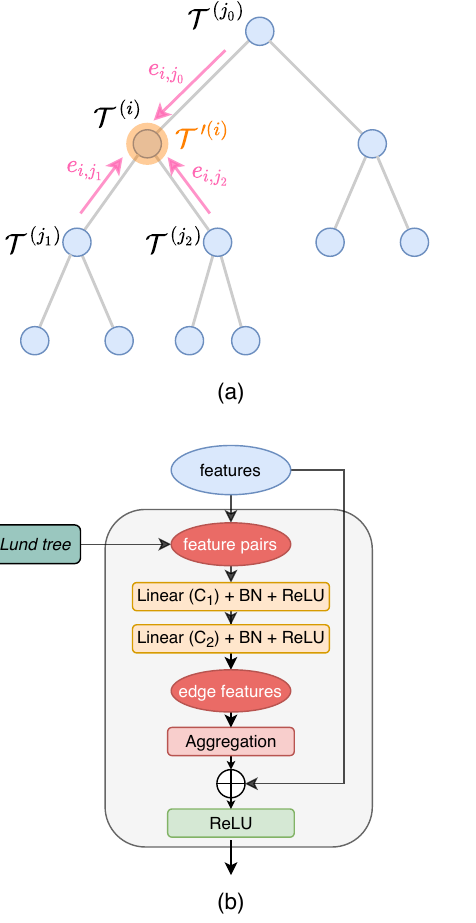
Figure 3 . (a) Illustration of the EdgeConv operation on a node of the Lund tree. (b) Architecture of the EdgeConv block used in the LundNet model. (c) Architecture of the LundNet